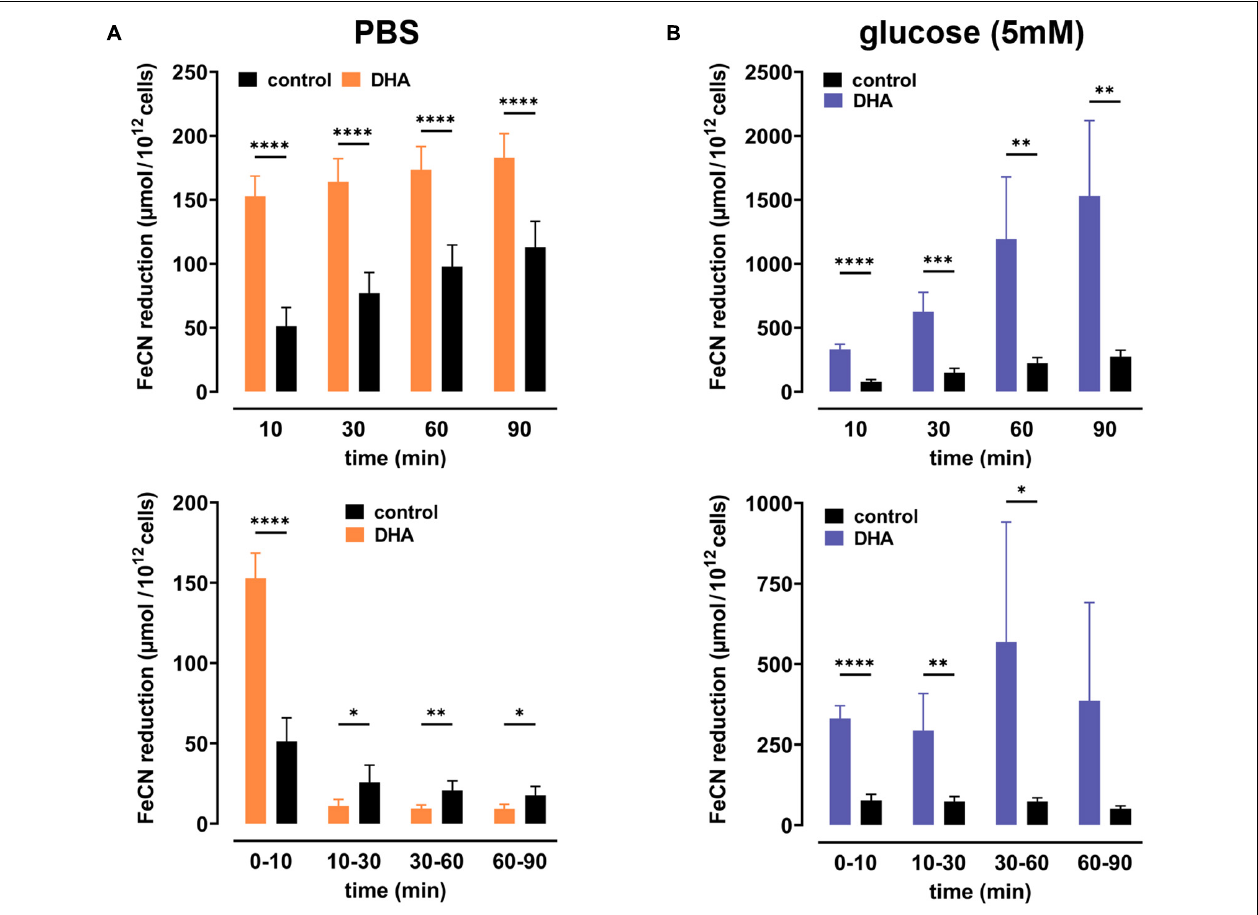
FIGURE 1 | Dehydroascorbic acid (DHA) uptake and glucose synergistically fuel erythrocyte plasma membrane electron transport. Erythrocytes ( n = 8) were pre-incubated in 2 mM DHA or PBS (=control, black) in the presence (blue) or absence (orange) of glucose. After washing, cells were suspended in 1 mM ferricyanide in PBS (A) or PBS containing 5 mM glucose (B) . Aliquots were removed at indicated time points and the amount of ferrocyanide in supernatants assessed as described in section “Materials and Methods.” Mean values of reduced ferrocyanide are given in µ mol/10 12 cells and shown both as cumulative values (upper panels) and amount generated between time points (lower panels), respectively. Please mind the different scales of the y-axes in panels (A,B) .